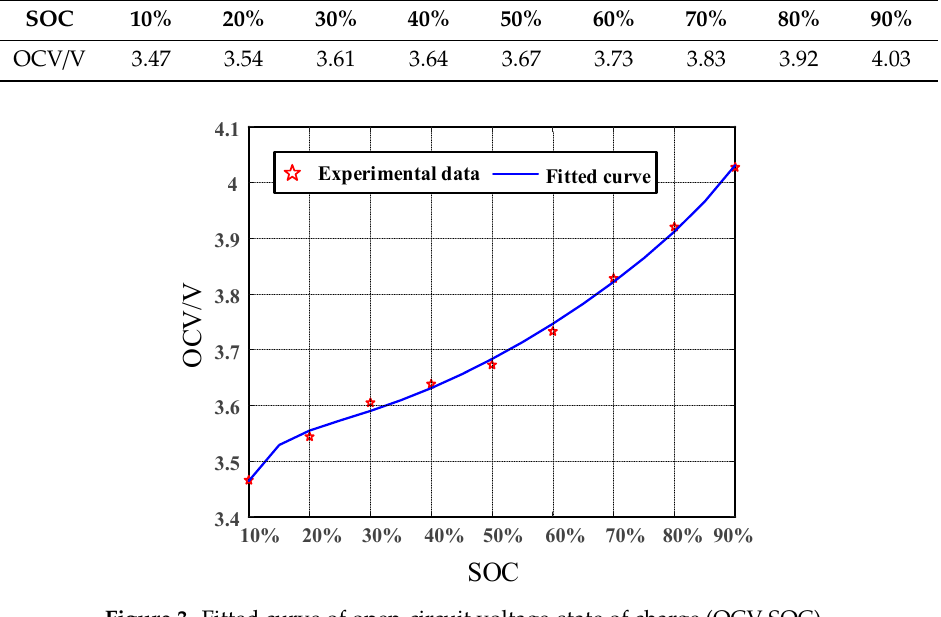
Table 2. Open-circuit voltage-state of charge (OCV-SOC) fitting curve parameter table.